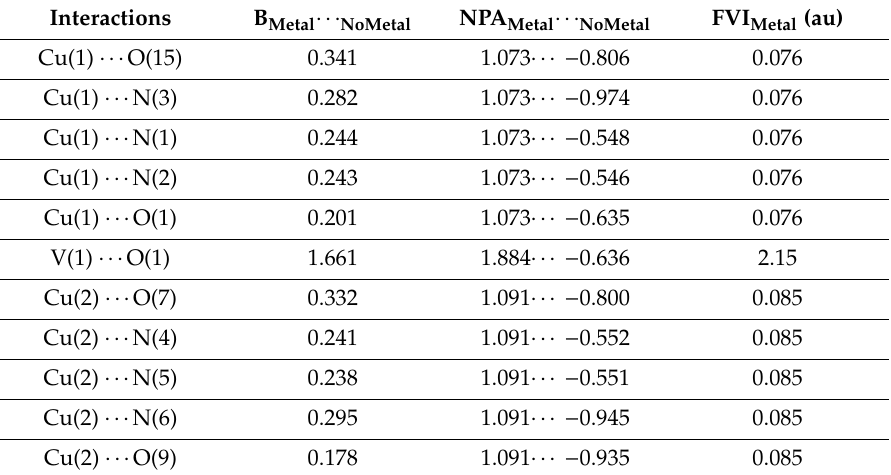
Table 5. Selected relevant noncovalent interactions, Mayer bond order (B Metal ··· NoMetal ), NPA spin density (NPA Metal ··· NoMetal ) and free valence index of the metal atoms (FVI Metal ) in Compound 1 at the M06-2X / Def2TZVP-LANL2TZ(f) level of theory using the ECP = LANL2TZ(f) for V and Cu in the CPCM model and water